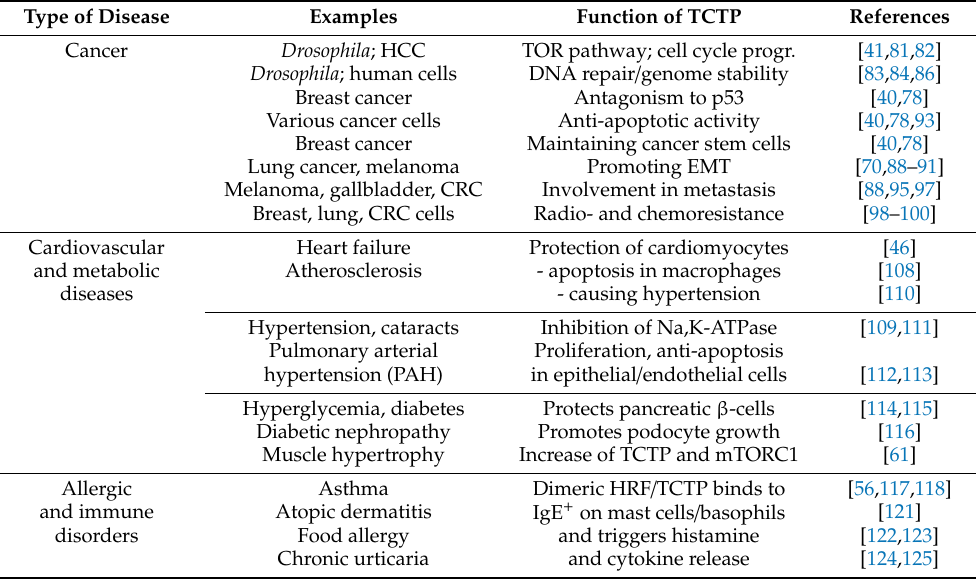
(Table 3): Asthma (reviewed in [56,117,118]), atopic dermatitis [121], food allergy [122,123], and chronic urticaria [124,125]. 4. A number of peptide and other inhibitors of TCTP / HRF showed some promise in alleviating symptoms elicited by this molecule in the context of allergic diseases [56]. Table 3. Dysregulation of TCTP in disease